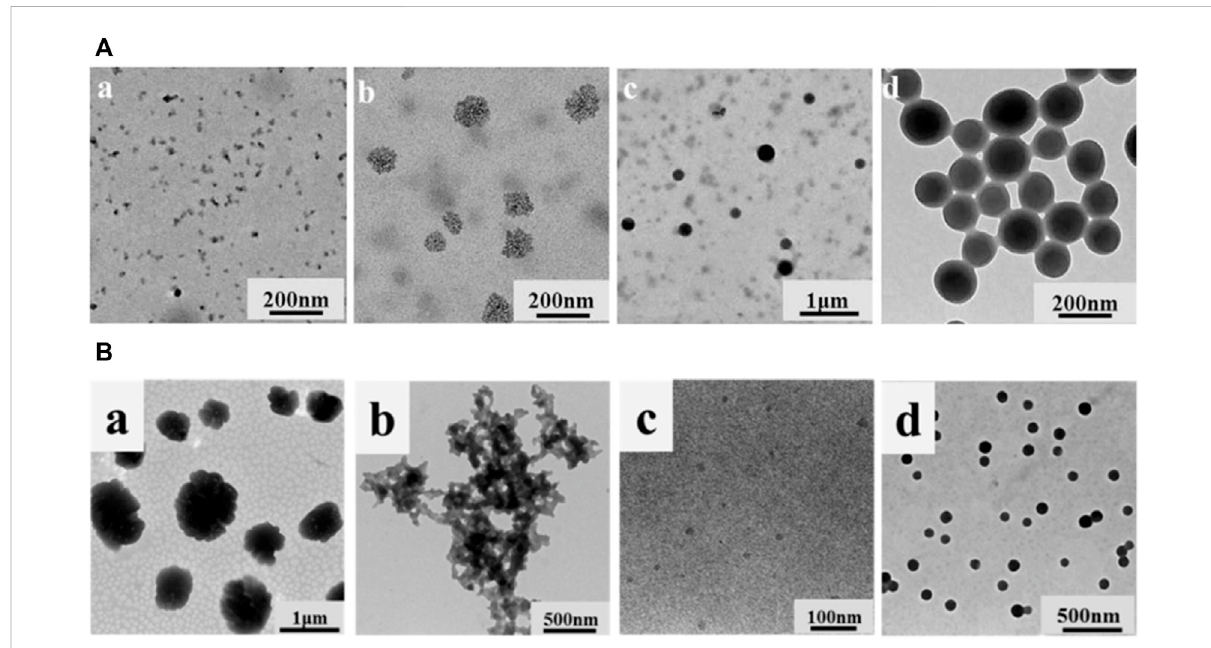
FIGURE 9 (A) TEM images of the samples at different water contents (Li et al., 2017) (B) TEM images of (a) QAL, (b) m(SDBS)/(QAL) = 0.6 complex, (c) m(SDBS)/m(QAL)=0.6complexsolutioninethanol,and(d)colloidalspheresfromthem(SDBS)/m(QAL)=0.6complex(Lietal.,2018). (A)